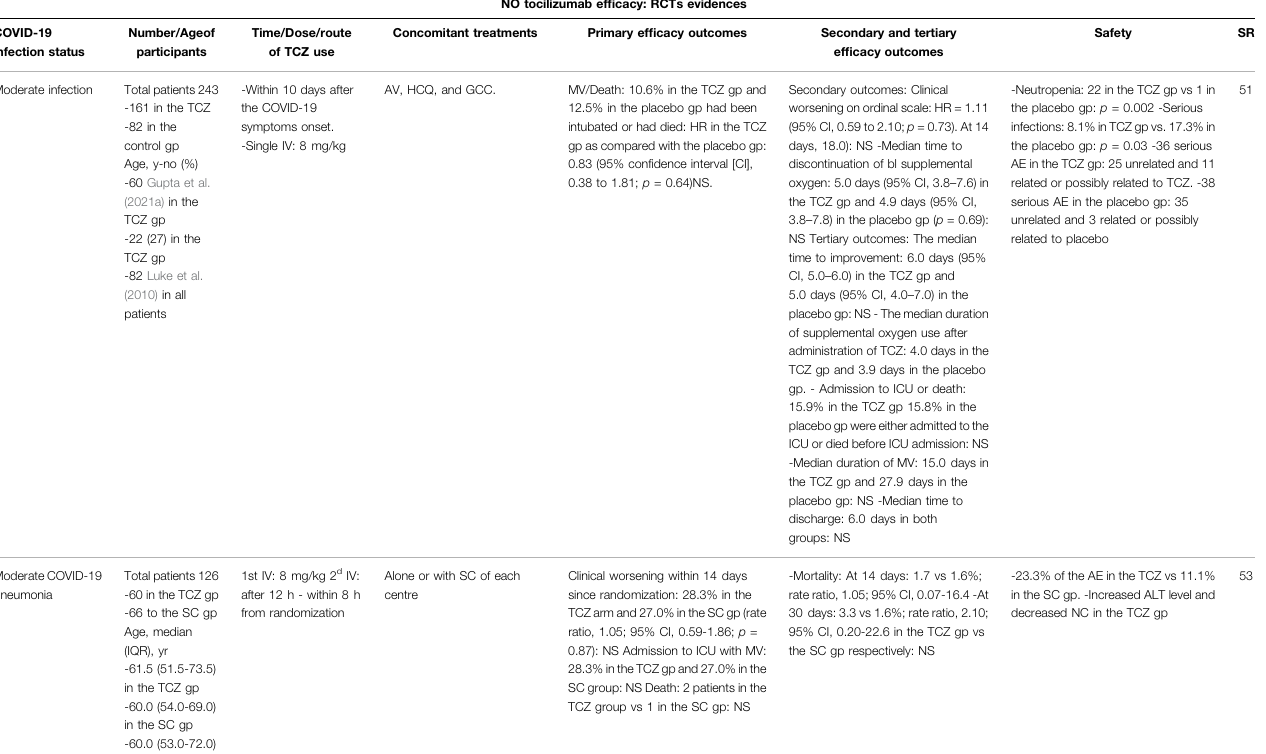
TABLE 1 | A Selective List of Randomized Clinical Trials Highlighting the Ef fi cacy, as well as Non-ef fi cacy, of Tocilizumab in COVID-19 Patients at Different Stages of the Infection Severity. NO tocilizumab ef fi cacy: RCTs